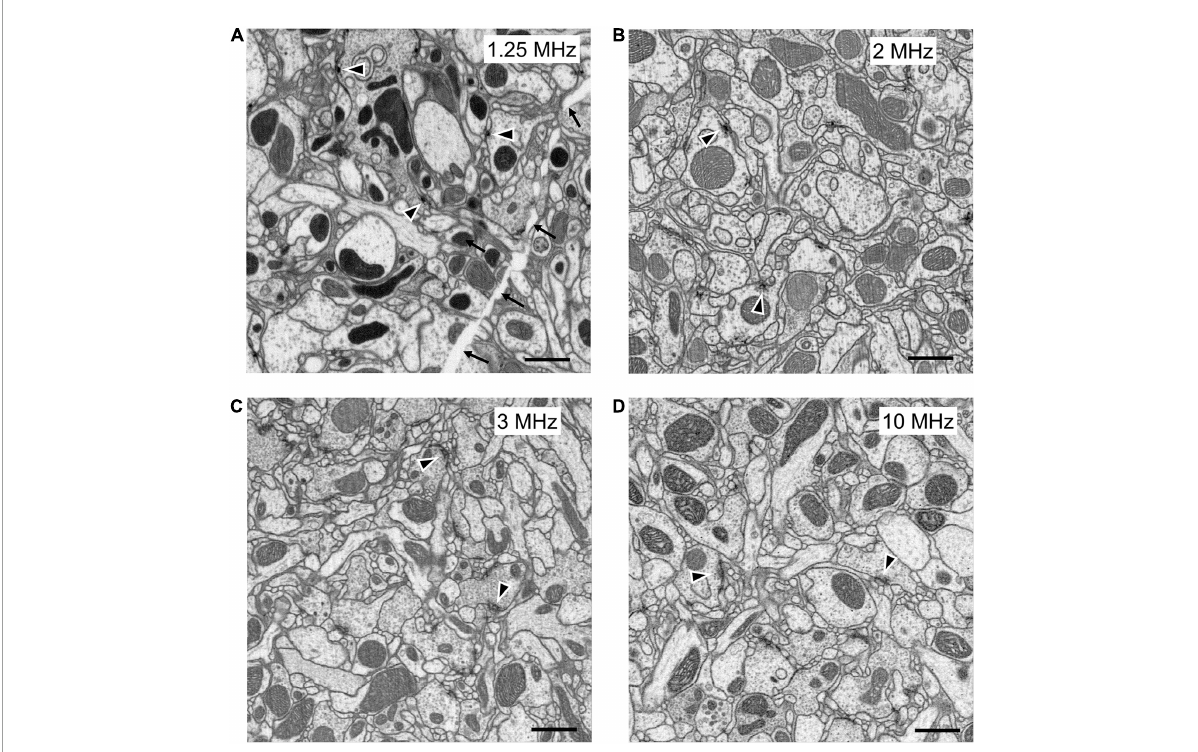
FIGURE5 FIB-SEM images, from samples prepared with different methods at different scan rates. All produce images of comparable quality, collected at different imaging speeds. (A) High-pressure freezing with freeze substitution, HPF-FS to compare with (B) progressive lowering of temperature and low-temperature staining (PLT and LTS). (C) Heavy metal enhanced PLT method scanned at 1.5 times the rate (3 MHz) as in (A,B) . (D) PLT-LTS progressive heavy metal enhancement, imaged more rapidly than the preceding (C) , according to Method 4 in Table 1 . Synaptic profiles (arrowheads) are clear in all panels but unavoidable cracks (arrows in A ) appear during HPF-FS specimen preparation. Scale bars: 1 µ m.